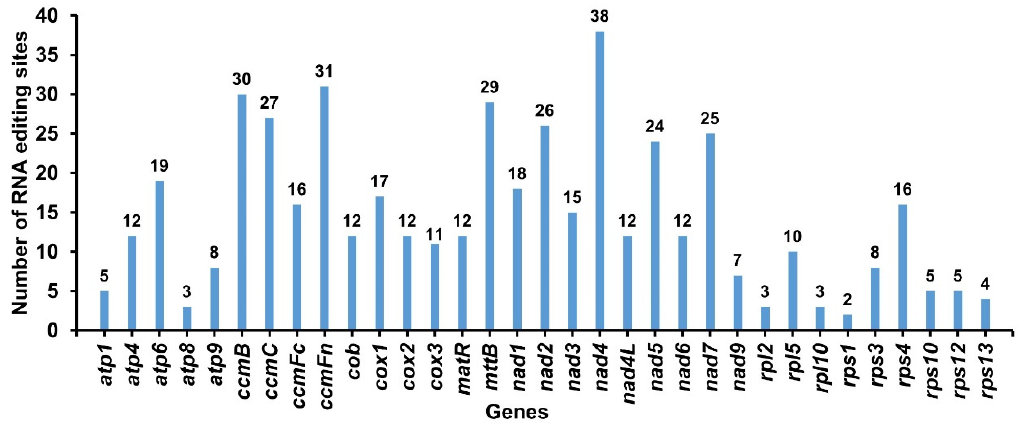
Figure 7. Prediction of RNA editing events in G. elegans mitochondrial genome. The horizontal and vertical coordinates indicate the gene name and the number of RNA edits, respectively.